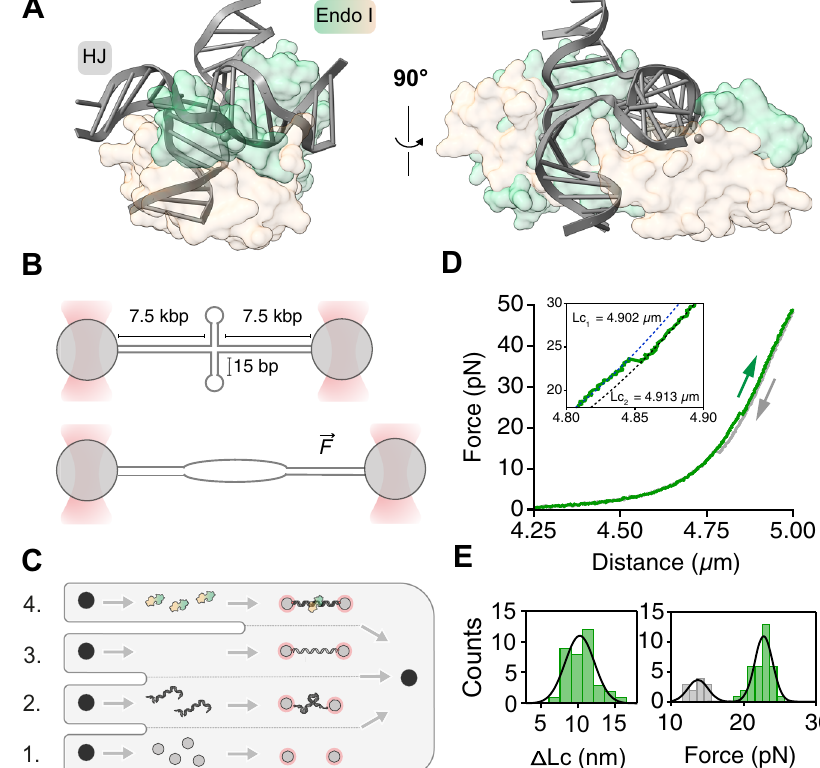
Fig. 1 | A four-way junction located at the centre of a 15 kbp dsDNA is stable below20pN.A Structureof thephage T7endonuclease Ihomodimer(pale yellow and green) bound to a four-way junction (grey). B Schematic of a dumbbell assembly.Biotinylated15kbpDNAwithafour-wayjunctionatitscentreistethered between optically trapped, streptavidin-coated polystyrene beads. Increasing the distance between the two beads generates a tensile force on the DNA leading to unfolding of the four-way junction. C Schematic of the micro fl uidic device used to trap, reconstitute and image the endonuclease bound to the DNA: (1) beads channel; (2) DNA channel; (3) buffer channel; (4) protein channel. D Force- extension curve (F-E) of the tethered DNA stretched from 0 to 50pN (green) and subsequently relaxed to 0pN (grey). The cycle was performed in the buffer channel. Inset: zoom on the discontinuity in the F-E curve which represents the